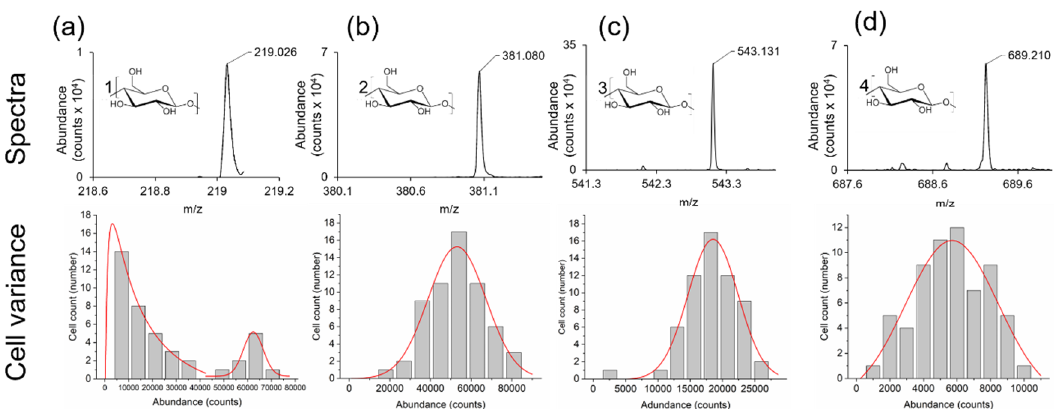
Figure 6. Exploring the variance in the abundance of saccharides within single cells of A. Cepa . i = 60 single cells. Monosaccharide ( a ), disaccharide ( b ), trisaccharide ( c ), tetrasaccharide ( d ). Spectra and structures for each of the saccharides (top row), and abundance (counts) for the saccharides within the 60 cells set (bottom row). Distribution fits are also shown (red lines).